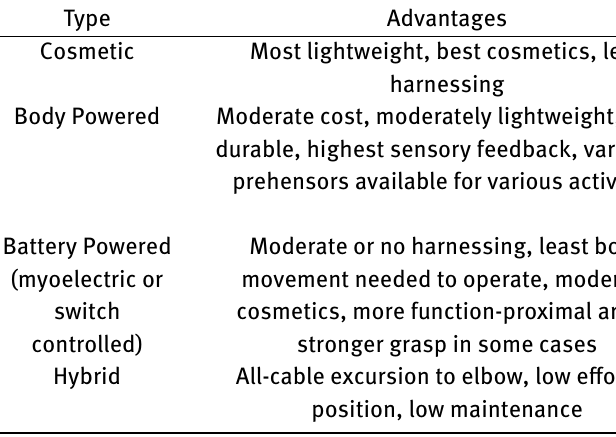
Table 1: Various Types of Upper Limb Prosthesis [6]